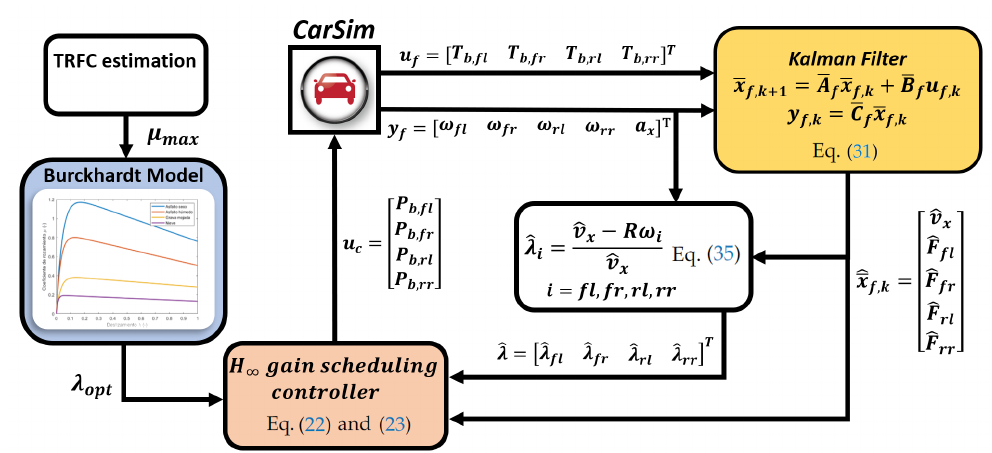
Figure 1. Scheme of the control architecture implemented in Simulink and CarSim [20–32].